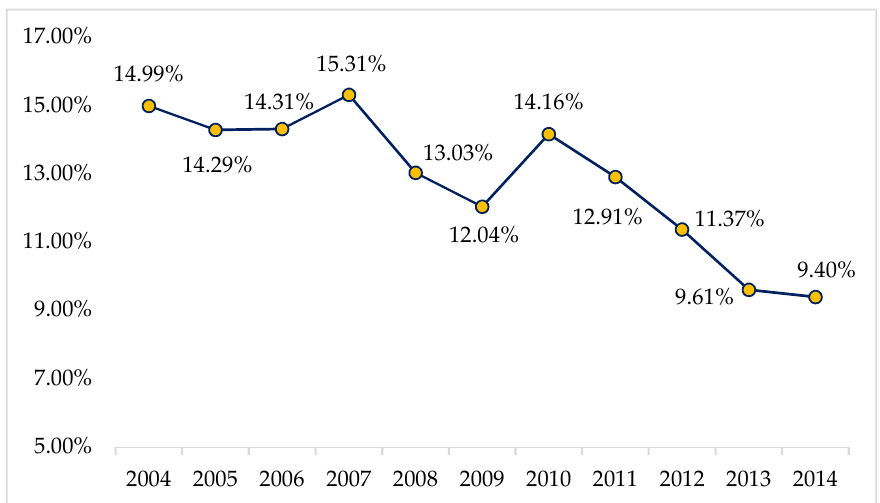
Figure 3. Nominal GDP growth rates from 2004 to 2014 for sample cities (Aggregated). Sample cities refer to the 113 Chinese municipalities, officially termed “key environmental protection cities” by the then Ministry of Environmental Protection of China in 2014.